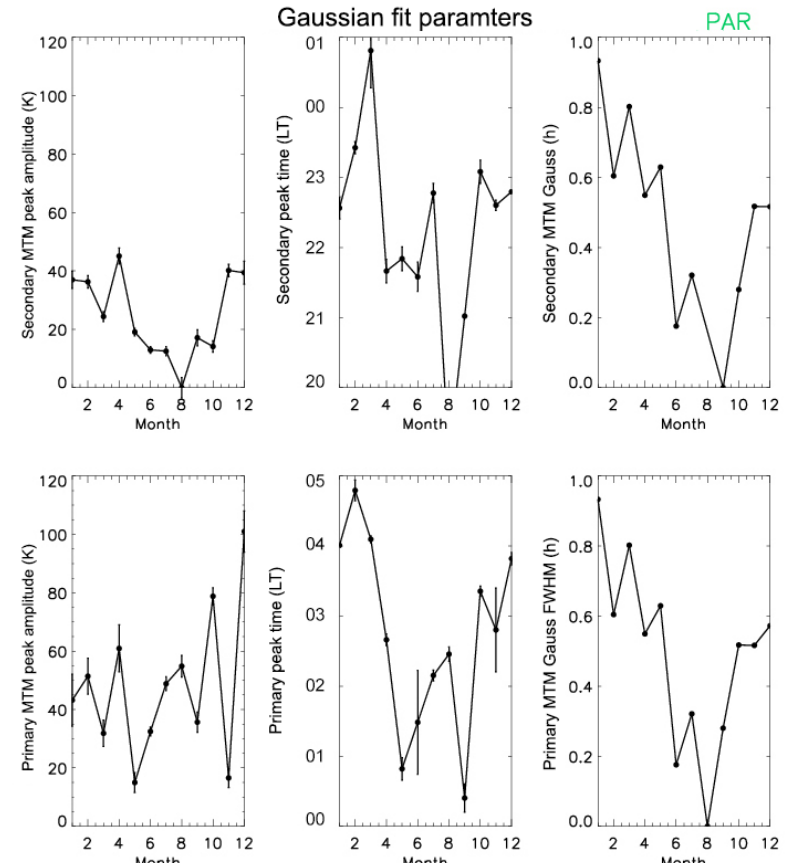
Figure 5. Coefficients for Gaussian fitting in Fig. 4 and their respective